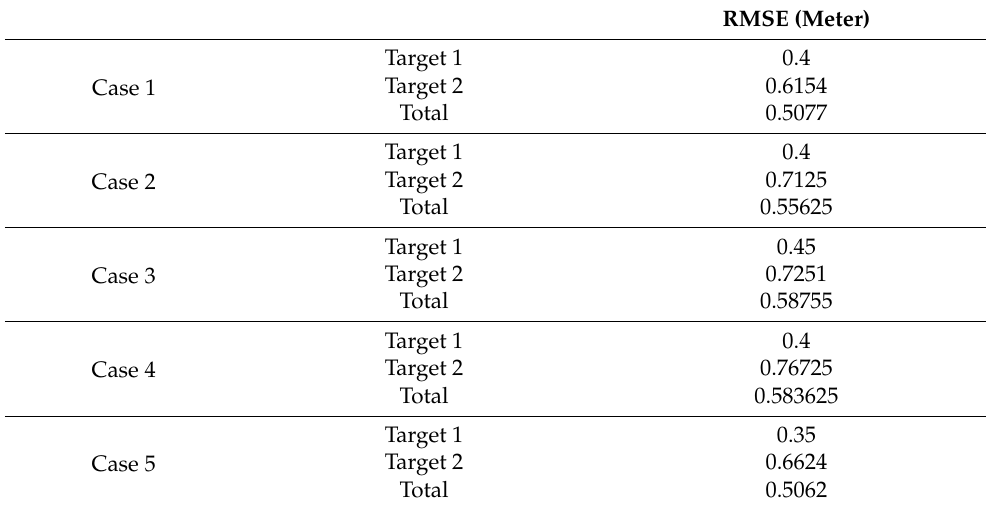
Table 7. RMSE value for multiple targets.